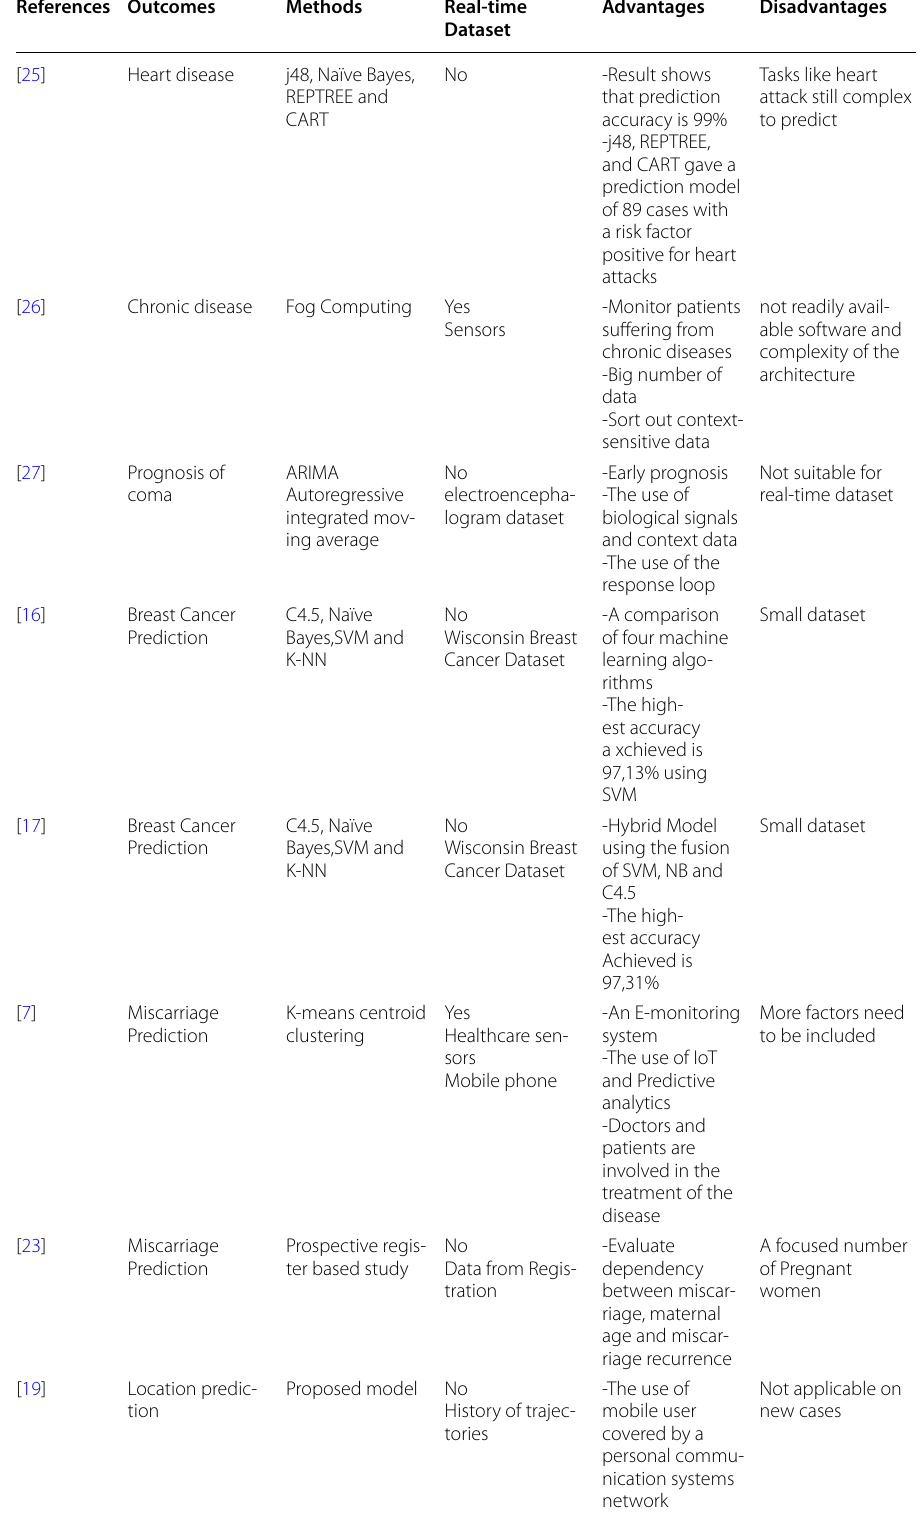
Table 1 Empirical Analysis of diseases prediction in healthcare system References